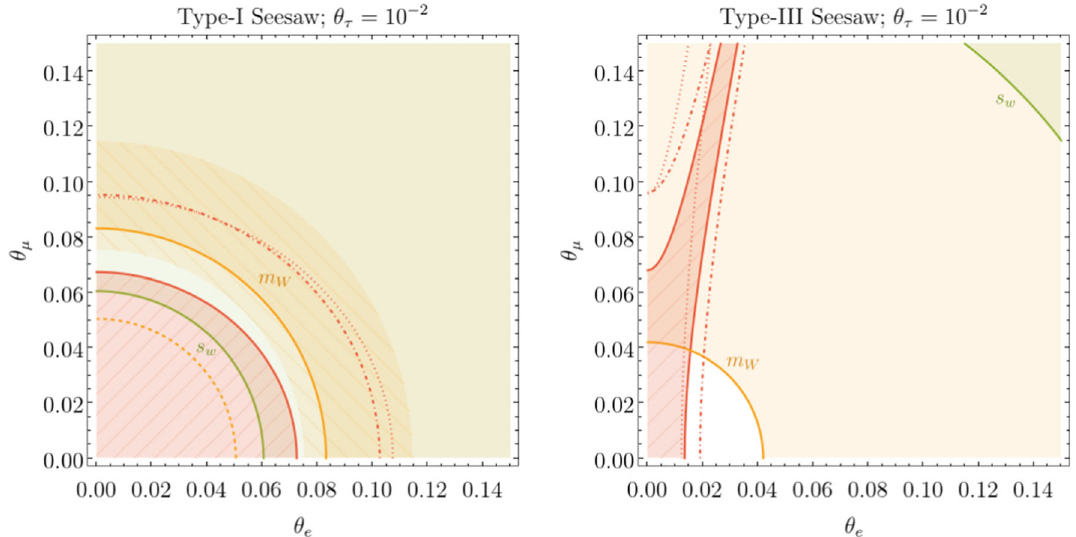
ivory regions for large θ e ,μ in the upper-right of the plots are excluded by measurements of both s w and m W . For Type-I Seesaw, the orange dashed line marks where the current experimental world average for m W is exactly accommodated, and in the orange-ruled region the CDF measurement [99] is explained at 2